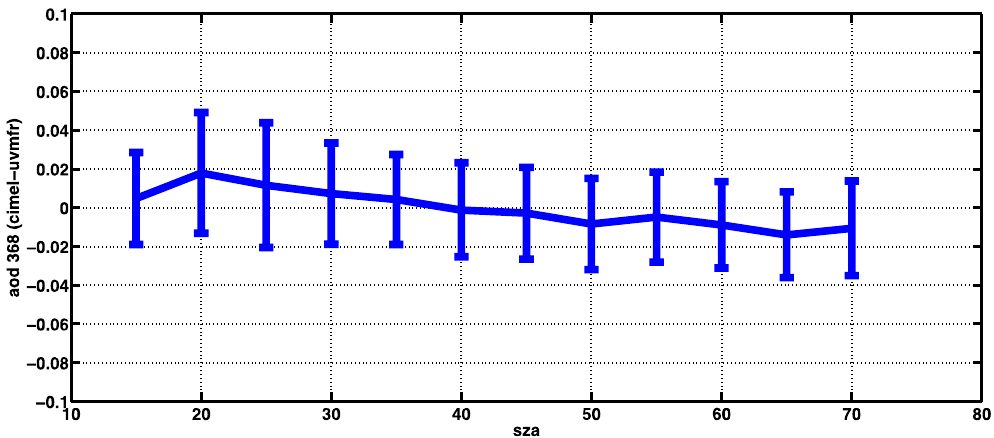
Figure 5. AOD differences between CIMEL and UVMFR at 368nm as a function of solar zenith